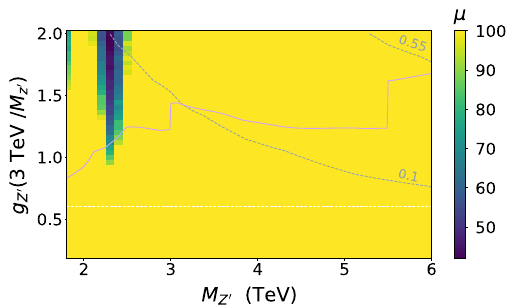
Fig. 14 μ for the CMS di-jet search [65] at each point in the scanned parameter space. The current search does not constrain the model. The solid purple line shows the current observed bound from all searches considered in this work. The dashed grey lines show the contour where (cid:10)/ M = 0 . 1 and 0.55, and the region between the dashed white line Z (cid:2) andthebottomoftheplotisfavouredbytheflavourandelectroweakdata at the 95% CL. Toward the extreme left-hand side of the plot, our pre- dictions become more inaccurate due to unaccounted-for O ( M 2 relative corrections